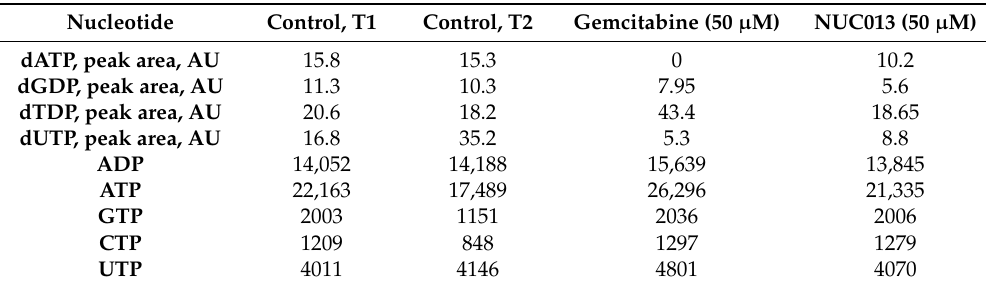
Table 1. Concentration of nucleotides from HeLa cell extracts comparing treatment with 50 µ M gemcitabine or NUC013 vs. control, where A: adenine, G: guanine, T: thymidine, U: uridine, d: deoxy, DP: diphosphate, TP: triphosphate and AU: absorbance units.